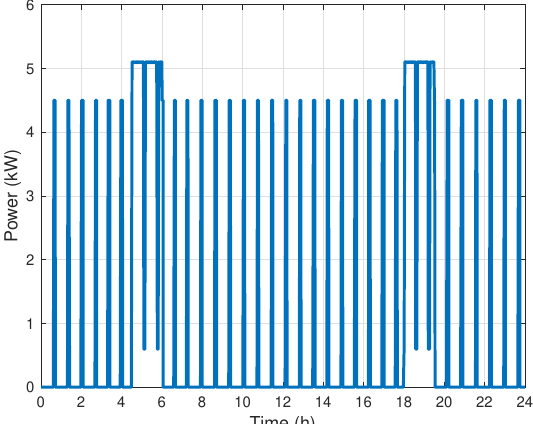
Figure A7. Shower shelter equipment